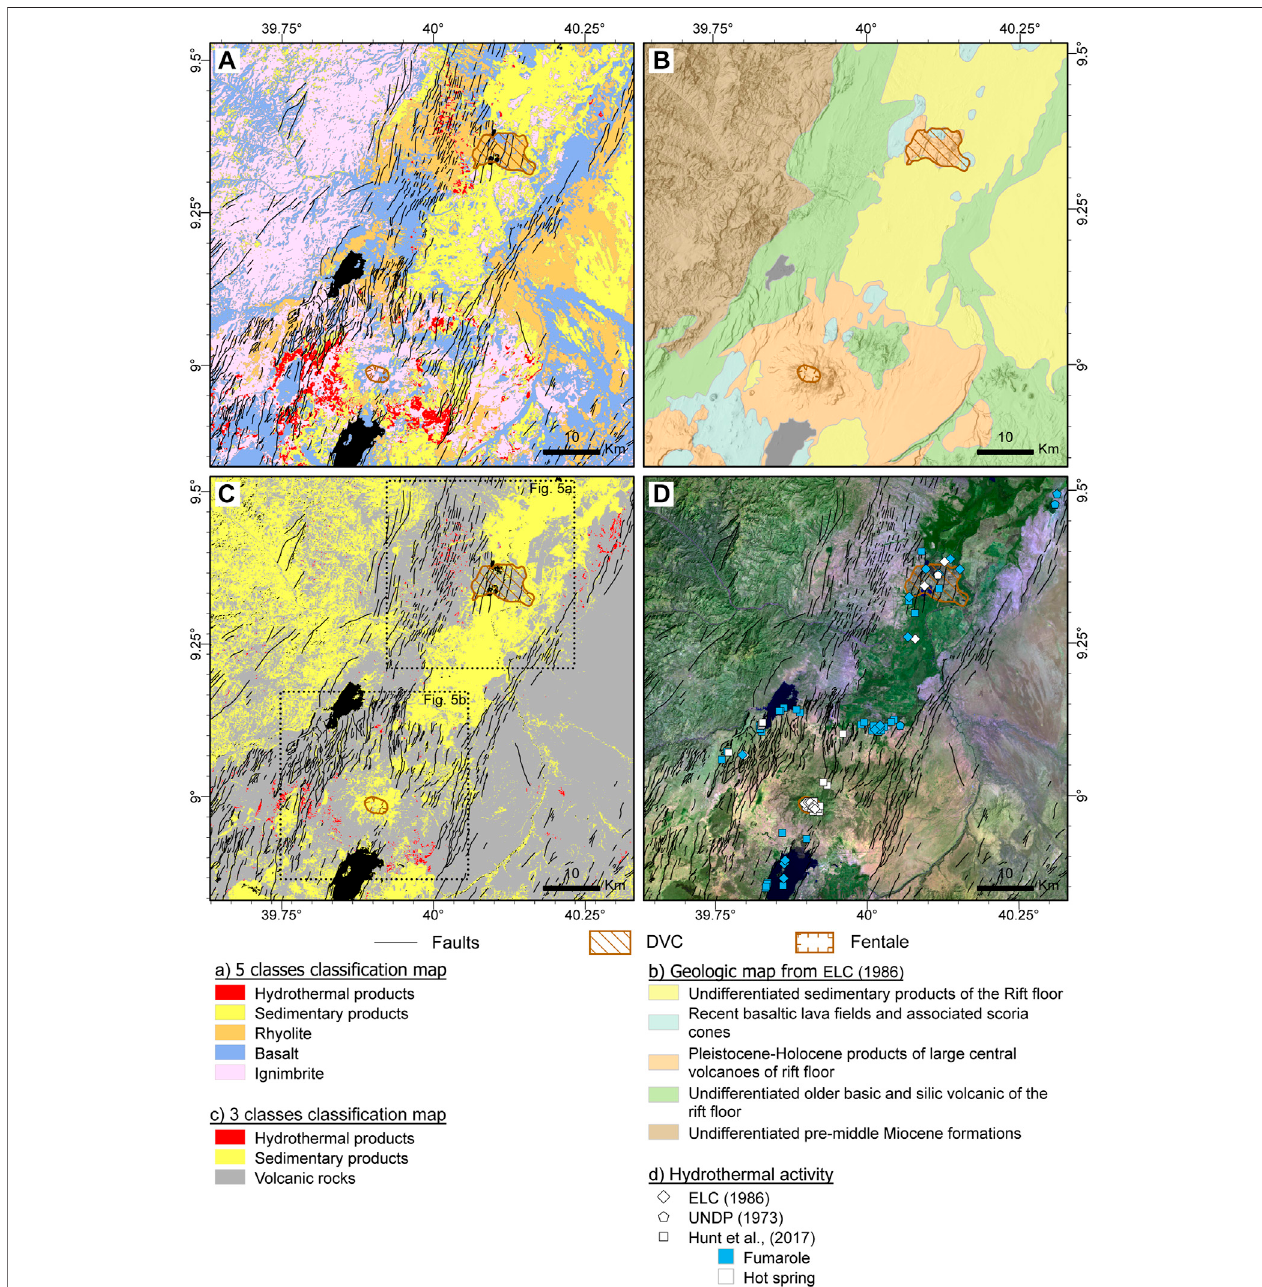
FIGURE 5 | (A) Classi fi ed Landsat 8 image assuming fi ve classes: geothermal deposits, basalts, ignimbrites, rhyolites, and sedimentary products. (B) Geologic map from ELC-Electroconsult (1987). (C) Classi fi ed Landsat 8 image assuming three classes: volcanic rocks, sedimentary rocks and geothermal deposits. (D) Map of hot springs and fumaroles overlaid on a Landsat 8 color-composite image 7, 6, 2.